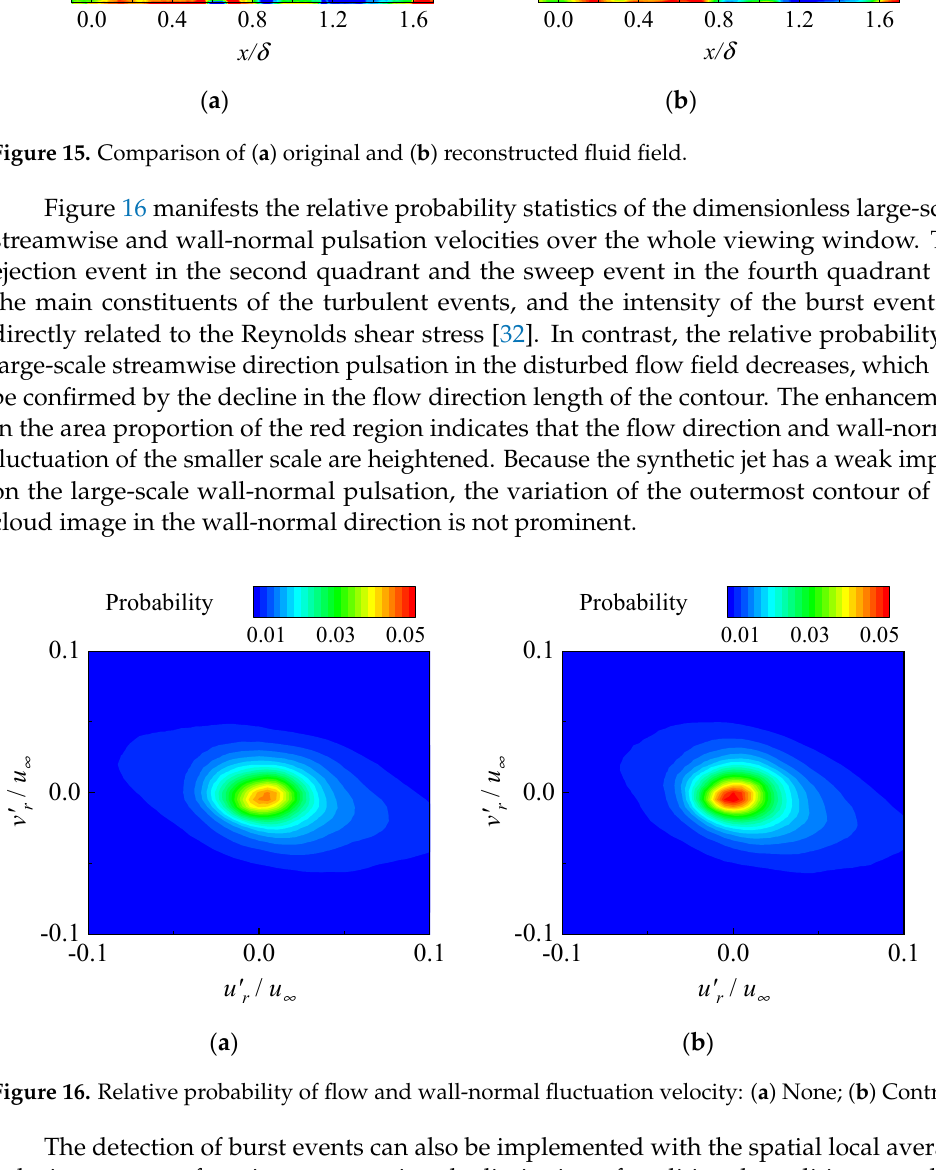
velocity structure function, overcoming the limitation of traditional condition